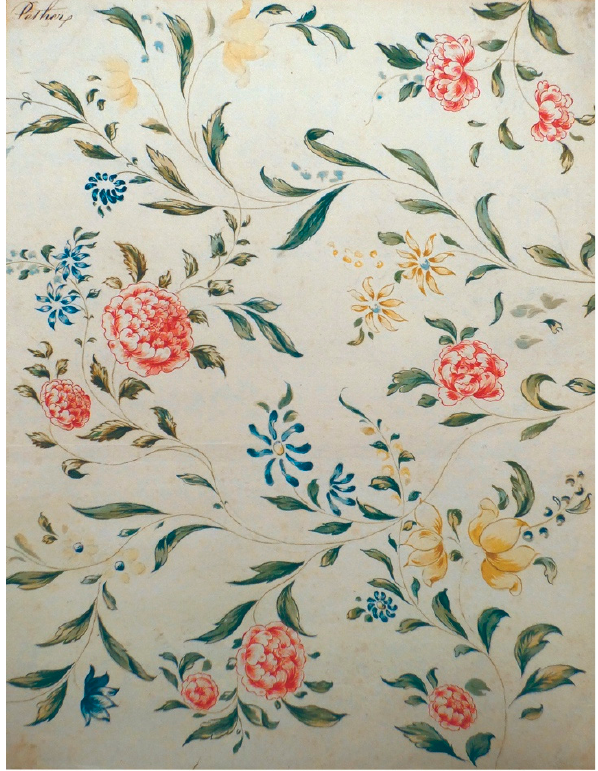
Figure 7. William Pether (1757), Flower Design , Royal Society of Arts, Manufactures and Commerce